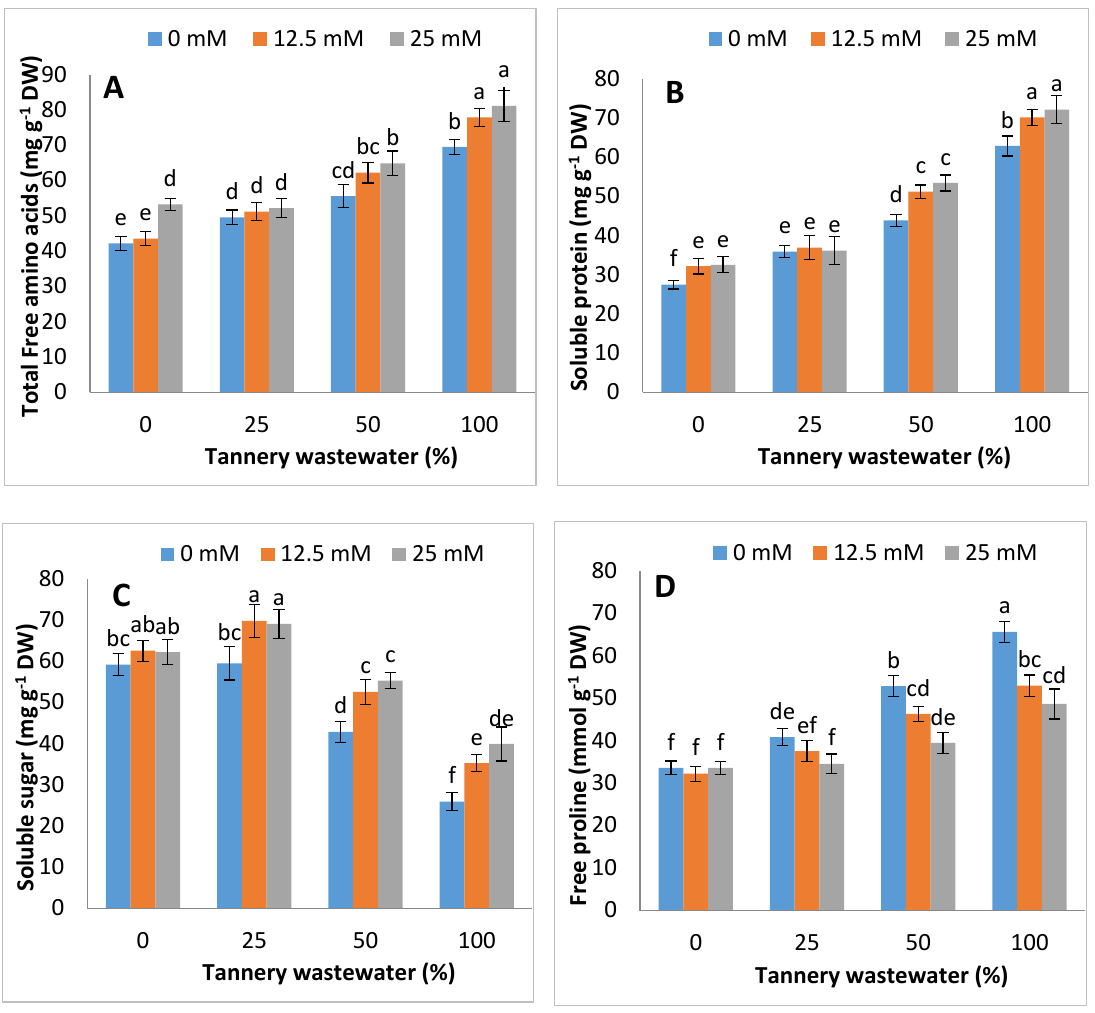
Figure 5. Graphs showing effect of foliar spray of Zn chelated lysine (0, 12.5, 25 mM) on total free amino acids ( A ), soluble protein ( B ), soluble sugar ( C ) and free proline ( D ) in maize plants, growing under 0%, 25%, 50%, 100% concentration of tannery wastewater. Values are means of three replicates. Statistical analyses were carried out by ANOVA, followed by Tukey’s Post-Hoc test.